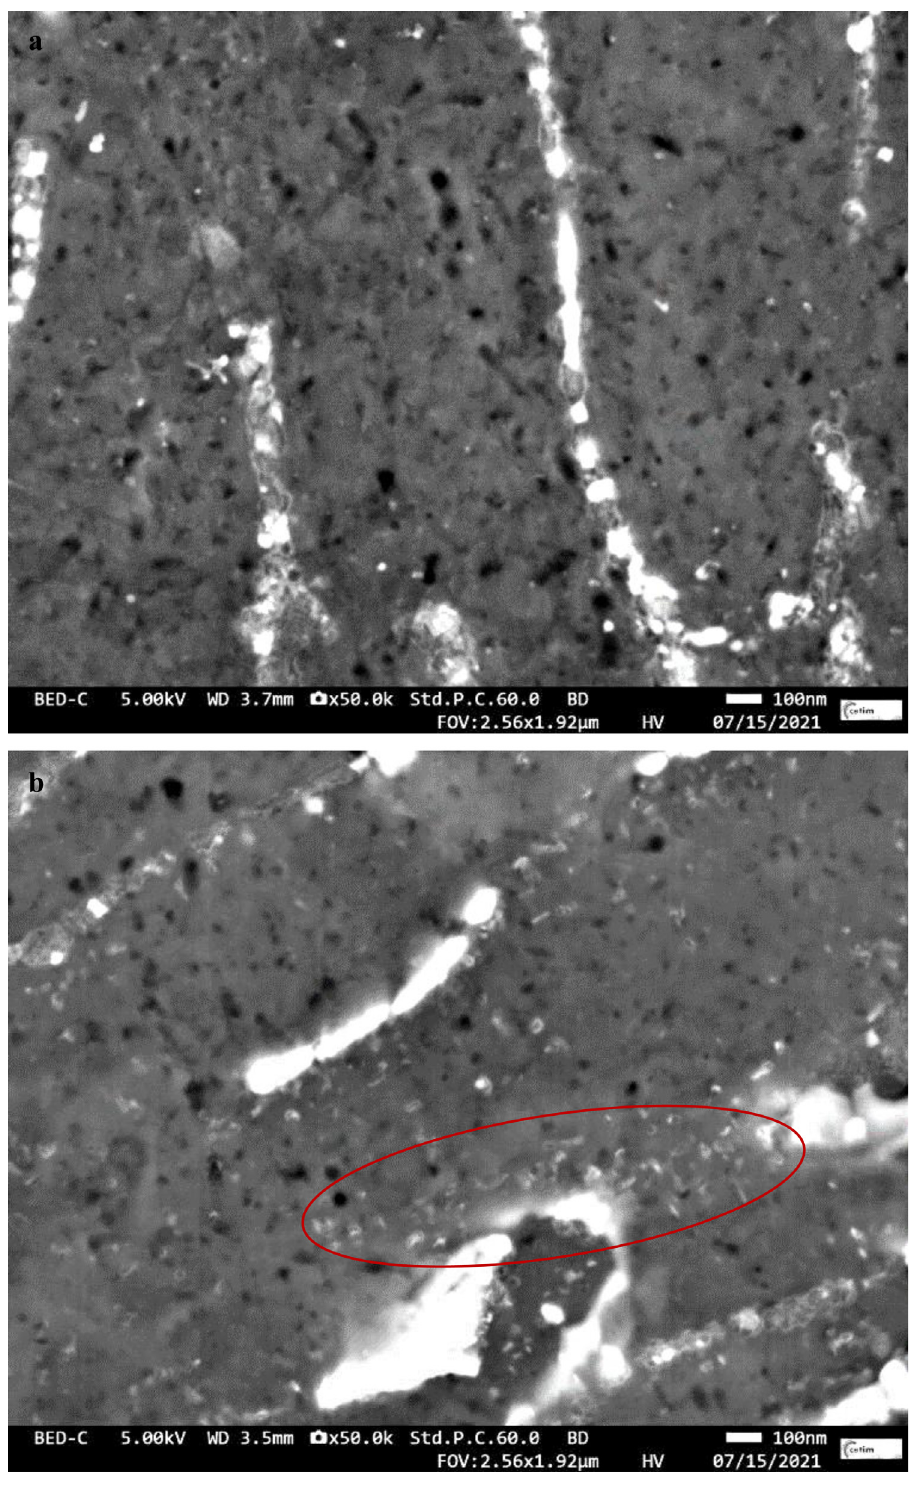
Fig. 5. Backscattered electron FEG-SEM examination (50,000x). (a) As-built AlSi5Cu3Mg alloy. (b) AlSi5Cu3Mg alloy in the direct aging temper (10 hours at 170 ° C). (c) AlSi5Cu3Mg alloy in T6